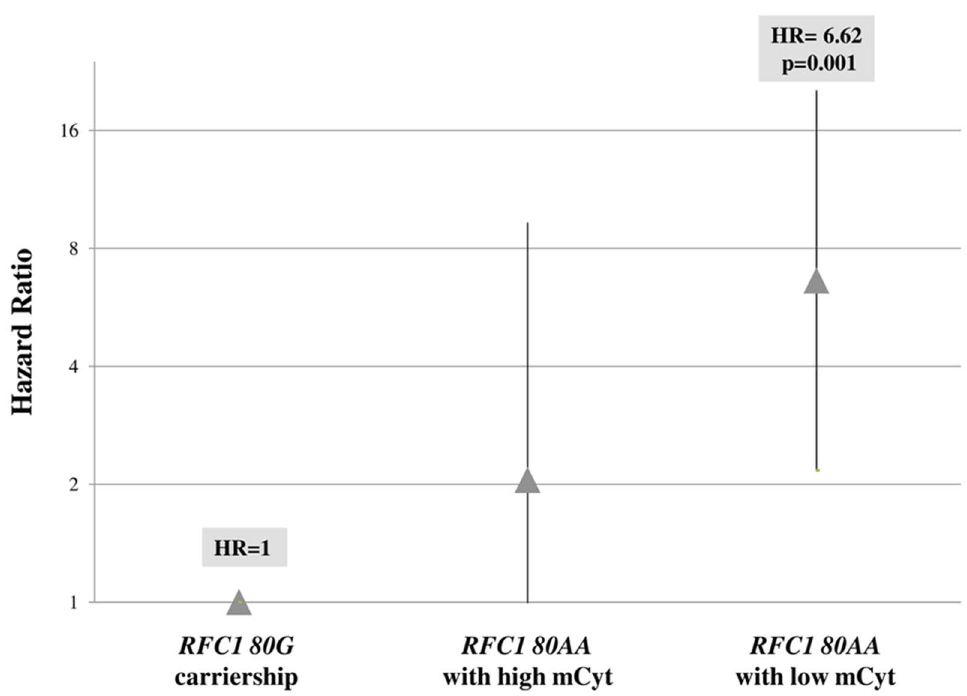
Fig 3. Mortality risk by Hazard Ratio for RFC1 80AA genotype with either high or low mCyt levels. The RFC1 80AA genotypewith low mCyt levels ( (cid:20) 5.34%), had a higherHazard Ratio (HR) as comparedto RFC1 80G carriership( RFC1 80GA plus RFC1 80GG ) (HR = 6.62, 95% CI 2.17–20.25,p = 0.001). The HR for RFC1 80AA genotypewith high mCyt levels ( > 5.34%)did not differ from the RFC1 80G carriershipgroup (HR = 2.05, 95% CI 0.45–9.32, p =